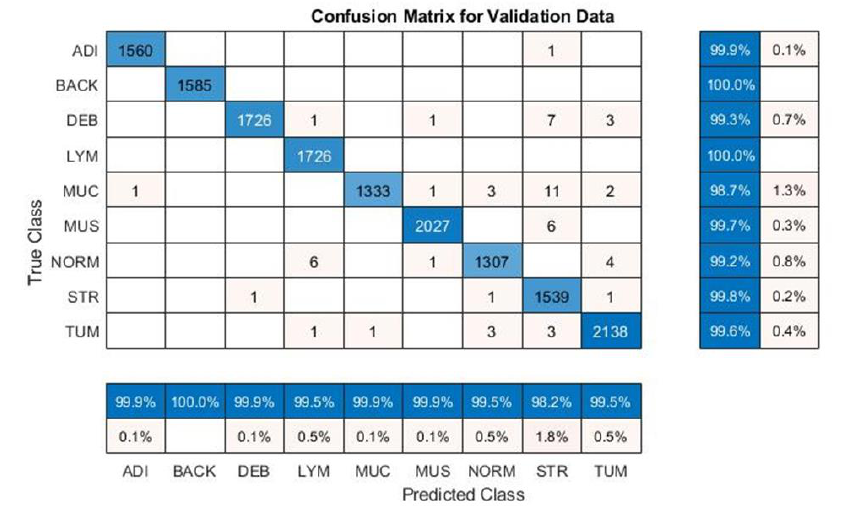
Figure 9. Experiment II: accuracy of nine classes (CRC-VAL-HE-100K).